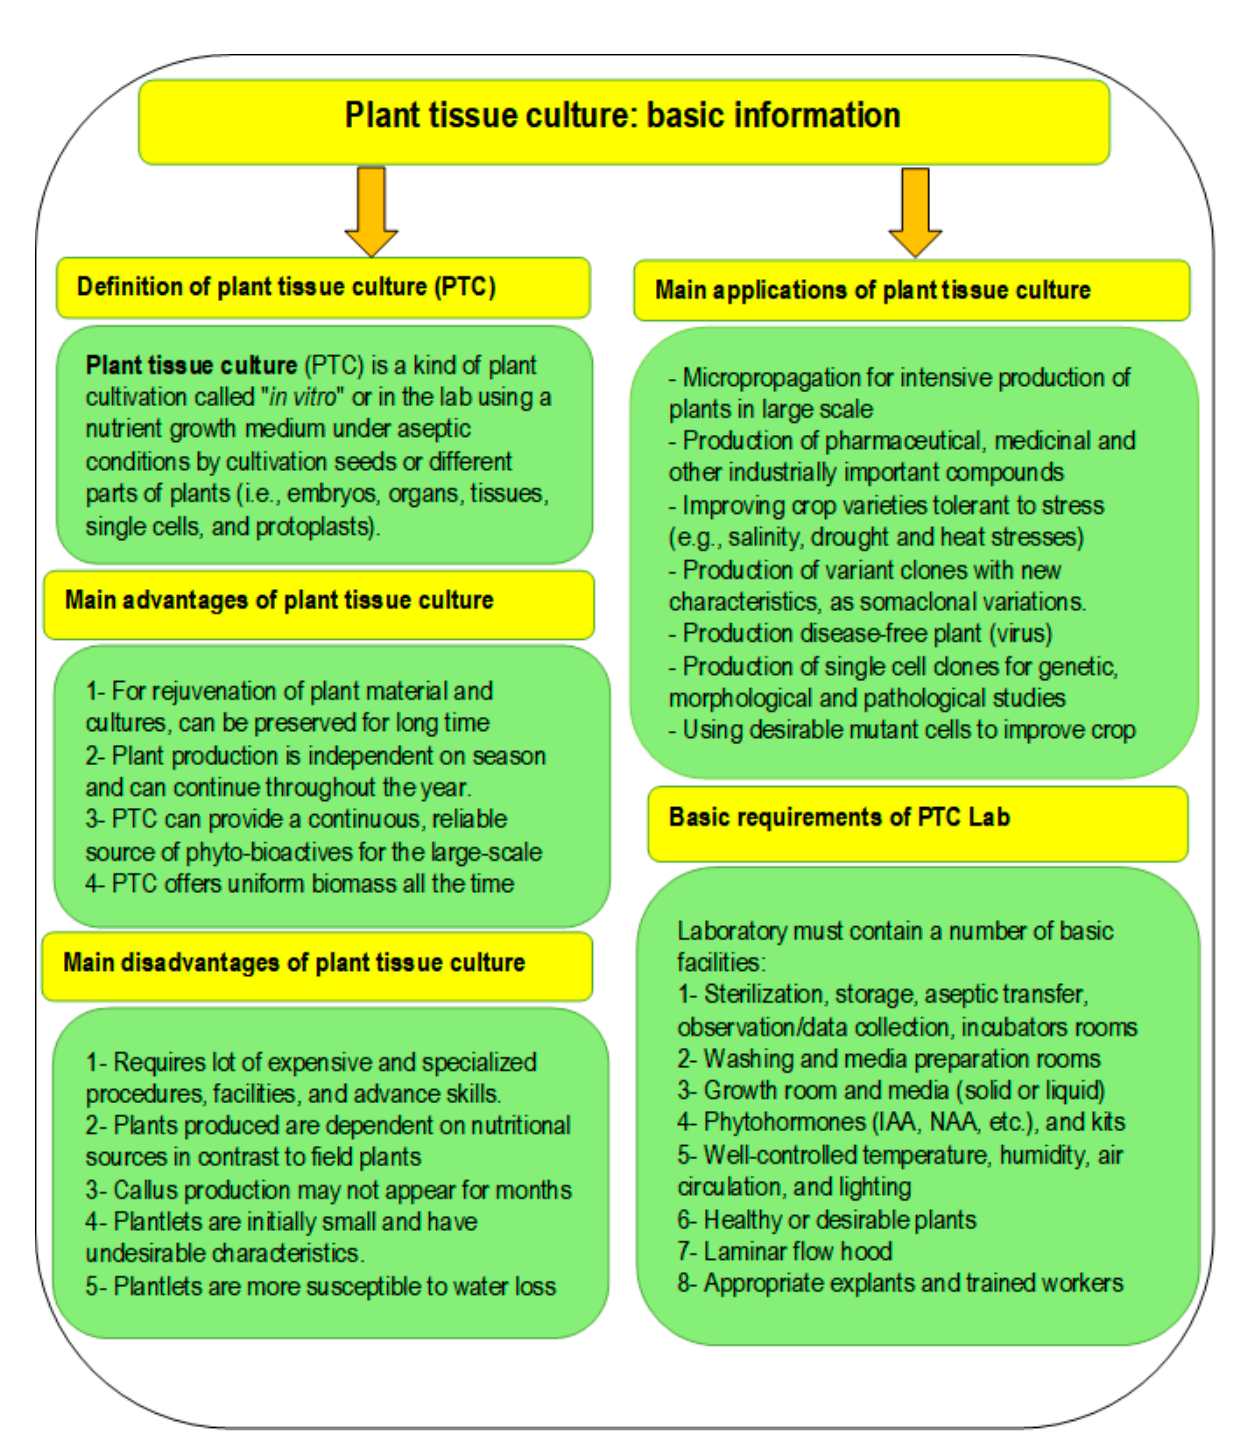
Figure 1. The basic information about the field of plant-tissue culture, including the definition, different applications, advantages, and disadvantages of this field. Sources: [9,32].